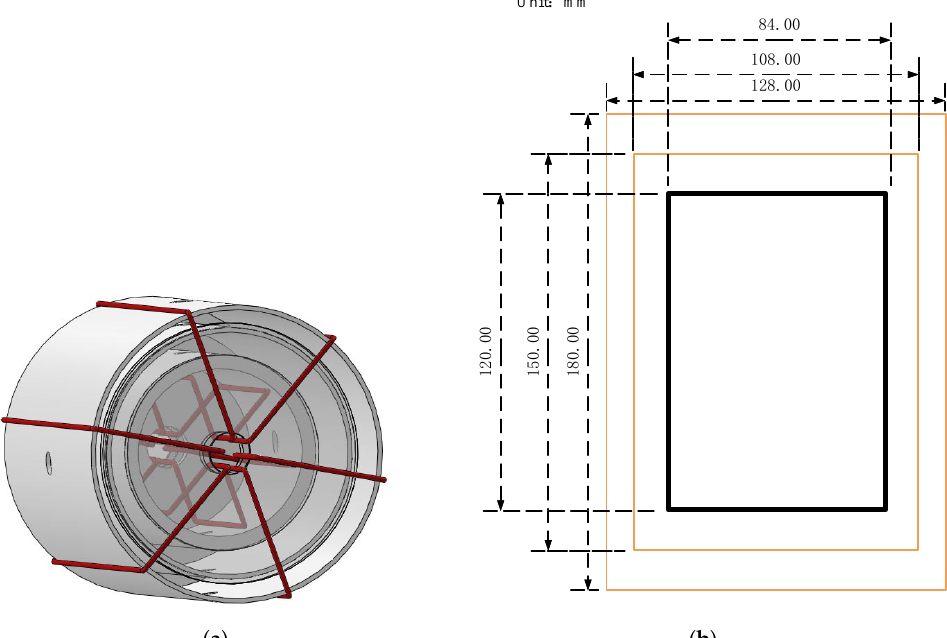
Figure 3. Internal structure of magnetic shield system composed of three shield layers of SERF co-magnetometer and method of wound demagnetizing coil. ( a ) 3D structure diagram ( b ) Plane dimension